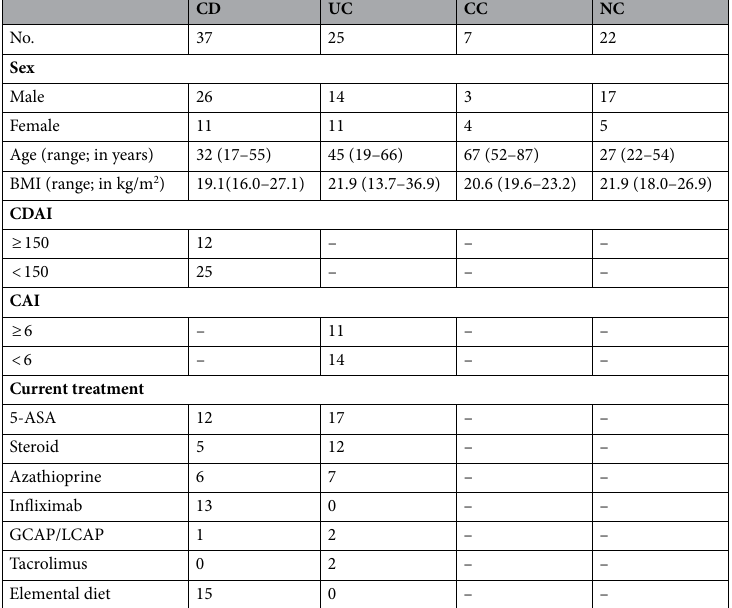
Table 1. Clinical characteristics of the patients in this study. CD Crohn’s disease, UC ulcerative colitis, CC colon cancer, NC normal control, BMI body mass index, CDAI Crohn’s disease activity index, CAI